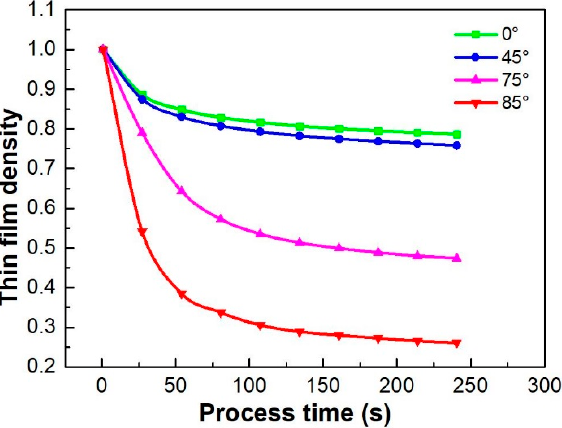
Figure 11. The relationship between surface roughness of silver film and process time.